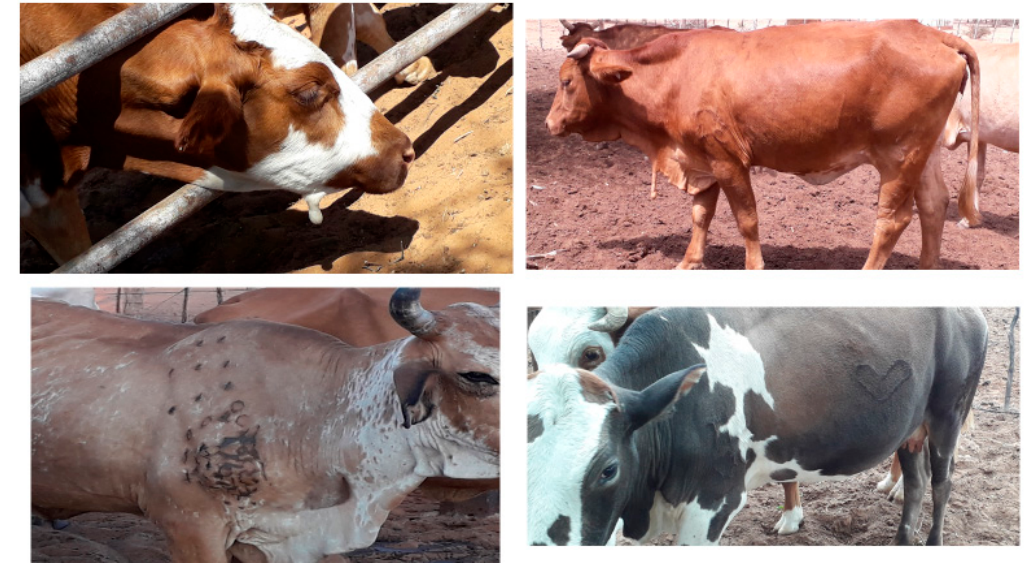
Appendix E. Pictures of Various Identification Markings at the Beef Cattle Herds in Namibia. Top Pictures Show the Skin-Flap Cuttings and Bottom Right Cow Has a Sign for Easy Identification and Bottom Left Shows a Cow with Multiple Brands for Animals 2020 , 10 , x FOR PEER Traditional Treatment